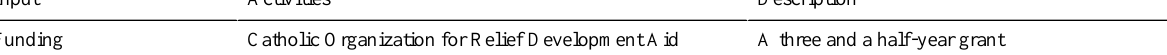
Table 1. Intervention description.